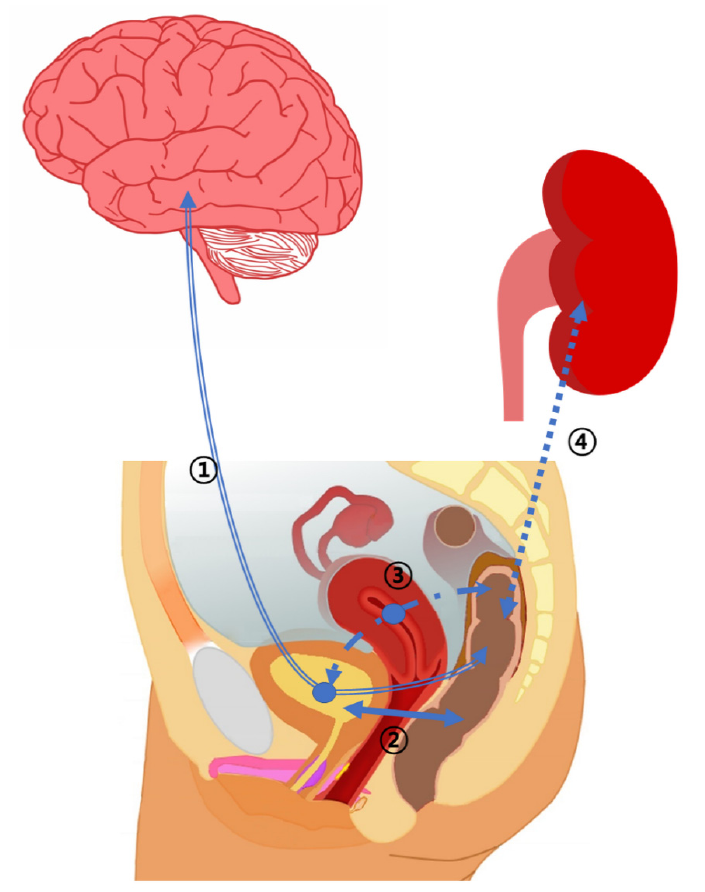
Figure 1. Bidirectionally communication between the gut, bladder, kidney, vagina, and brain. (1) Gut–bladder–brain axis, (2) Gut–bladder axis, (3) Gut–vagina–bladder axis, (4) Gut–kidney axis.